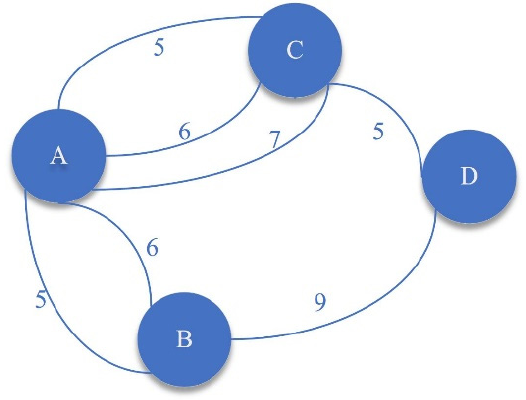
Figure 3. An example multi-graph.